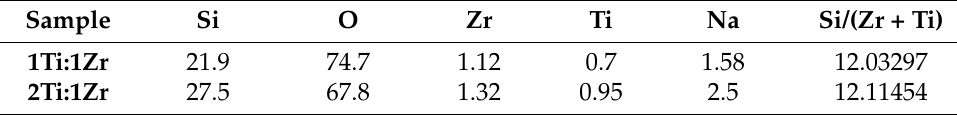
Table 3. EDX analysis of spherical shapes in different